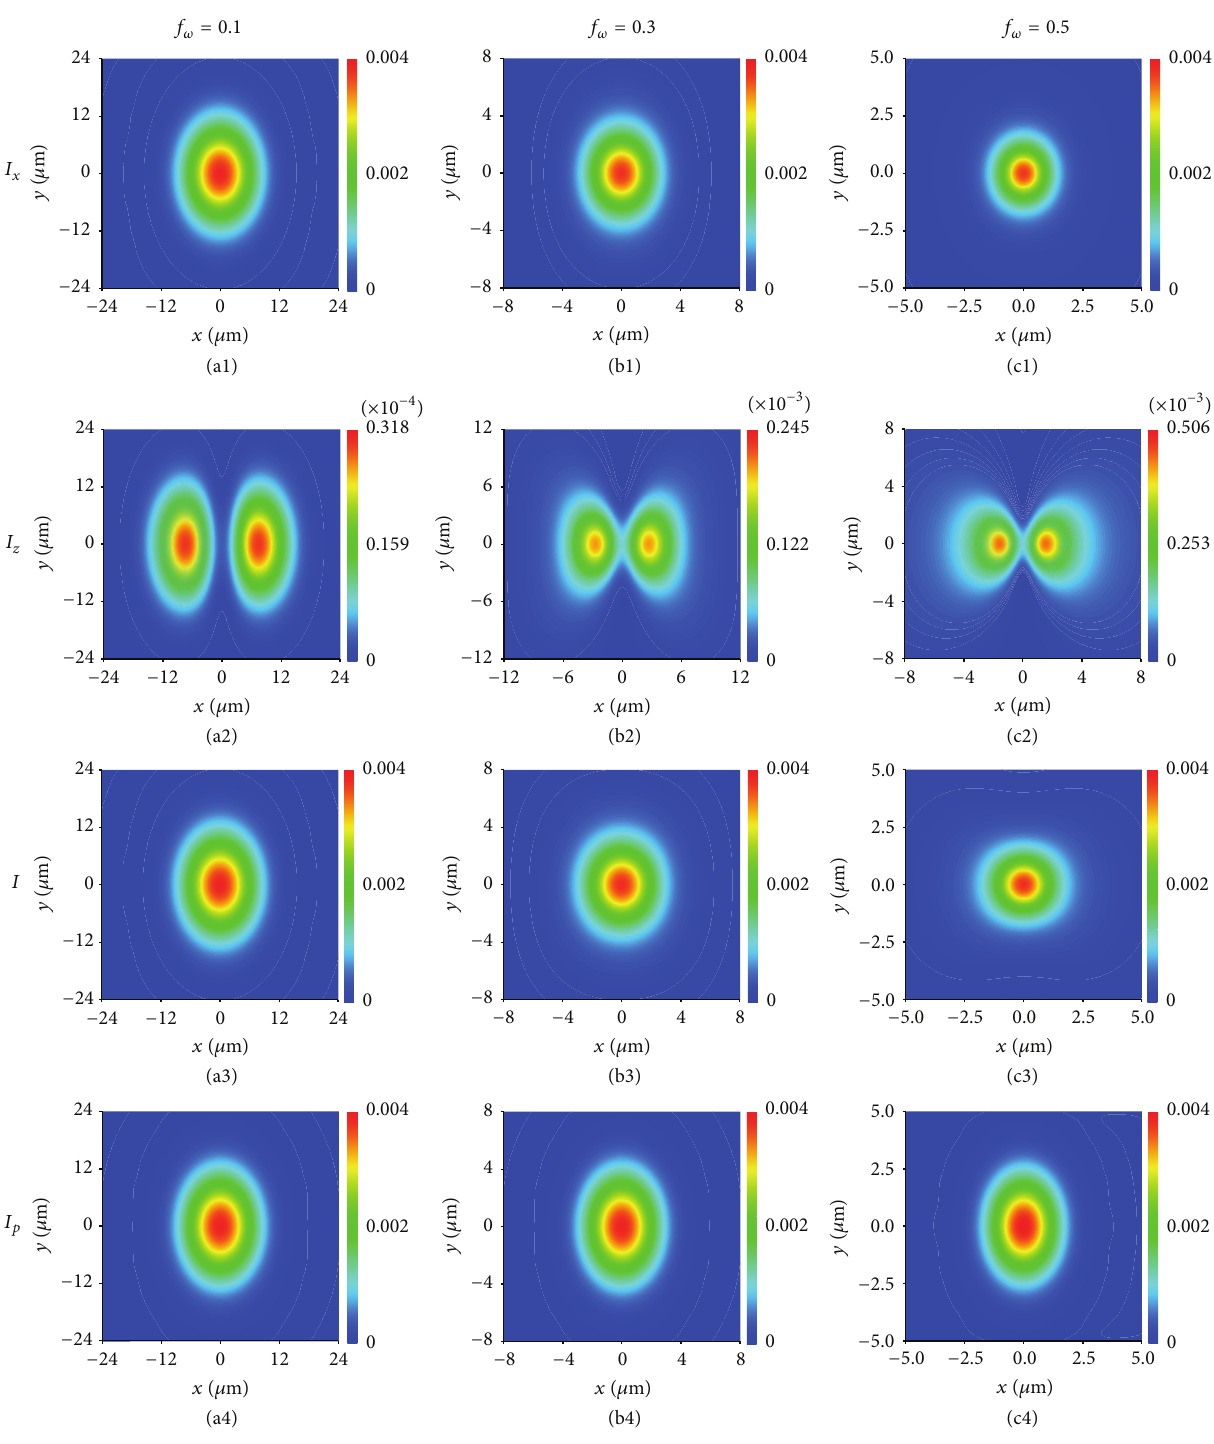
small and can be neglected; hence the beam profiles of total intensity distribution 𝐼 and corresponding paraxial result 𝐼